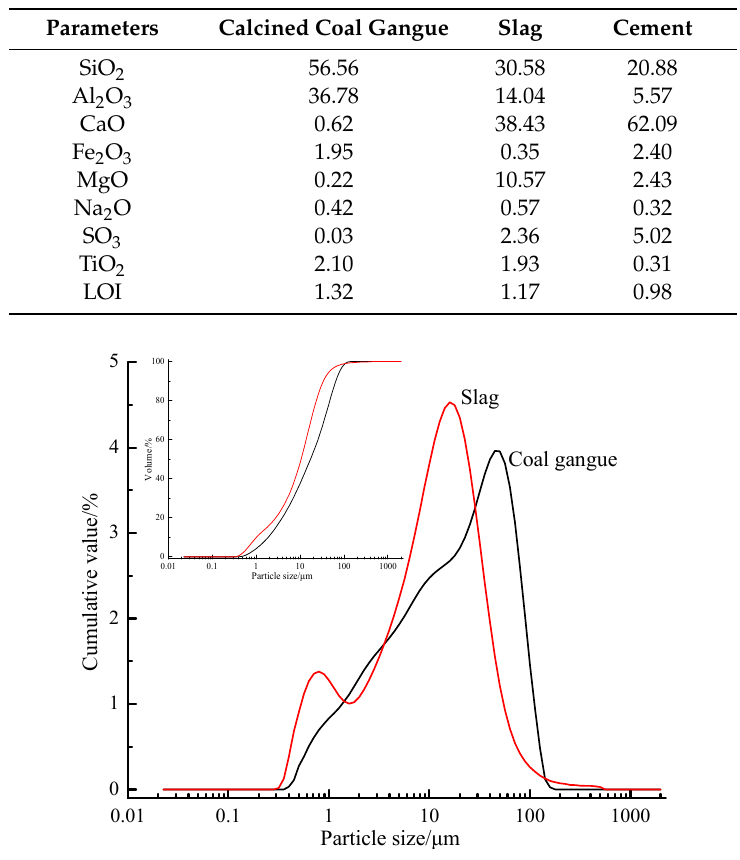
Figure 1. Calcined coal gangue and slag particle size analysis.